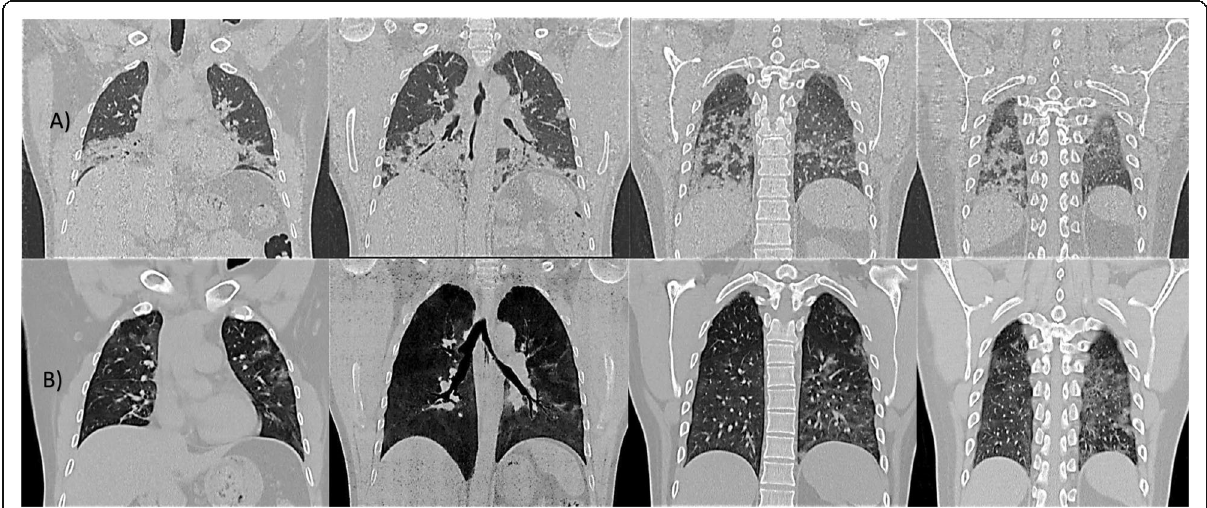
Fig. 3 Case 5: A 42-year-old male, without comorbidities, score 4 at the moment of the recruitment, with oxygen requirements through a nasal cannula. High-resolution CT chest: a day of admission (April 1st). There are right lung lower lobe and middle lobe extensive consolidations. Similar peripheral opacities noted in the left lung lower lobe and upper lobe. b Day 4 after treatment (April 13th, nebulization did on April 9th).